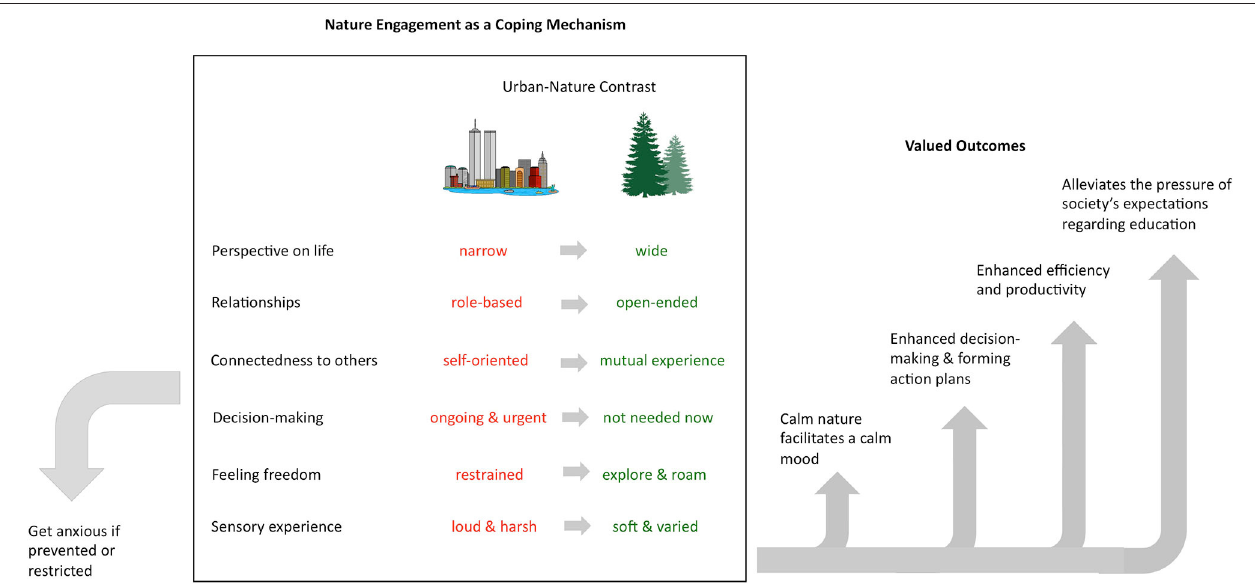
FIGURE 2 | A diagram of the themes in the study, organized to illustrate the multi-level pathways through which nature engagement as a coping mechanism leads to multi-level benefits to well-being. The themes outside the box are worded as in the Results and Discussion. However, within the box, the rest of the themes have been organized hierarchically, and the Urban vs. Nature theme has been used to contrast each of these perceptions between the two environments using material from participants’